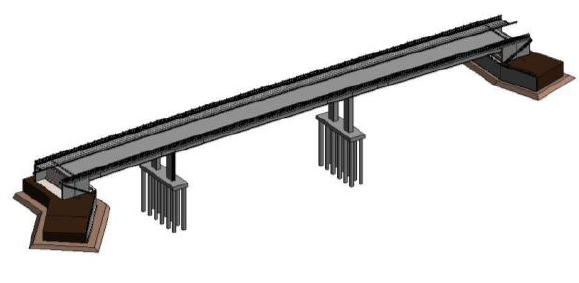
Figure 5 . The 3D model of the bridge.